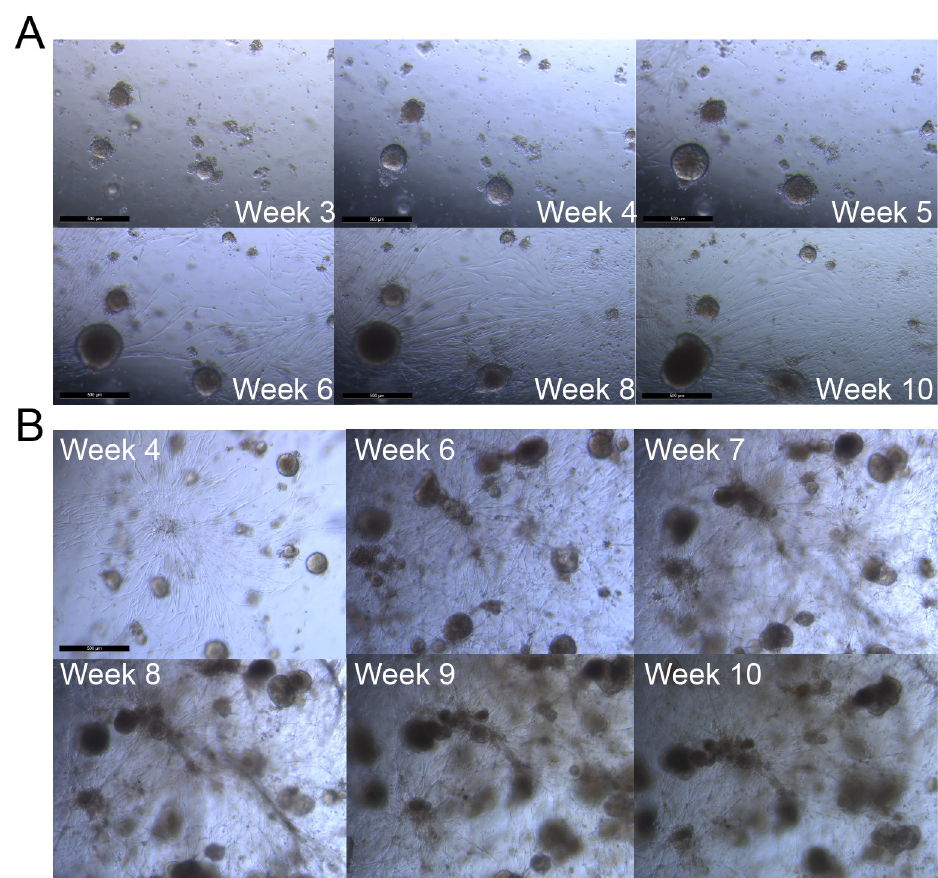
Fig 5. Bright field images of Tumor 11 showing growth of spheroids and fibroblast-like cells over time in 10 μ M erlotinib. Sets of images were collected from the same fields of view for two different wells (A and B) between Weeks 3–10 in culture. The scale bars are 500 μ m in length.